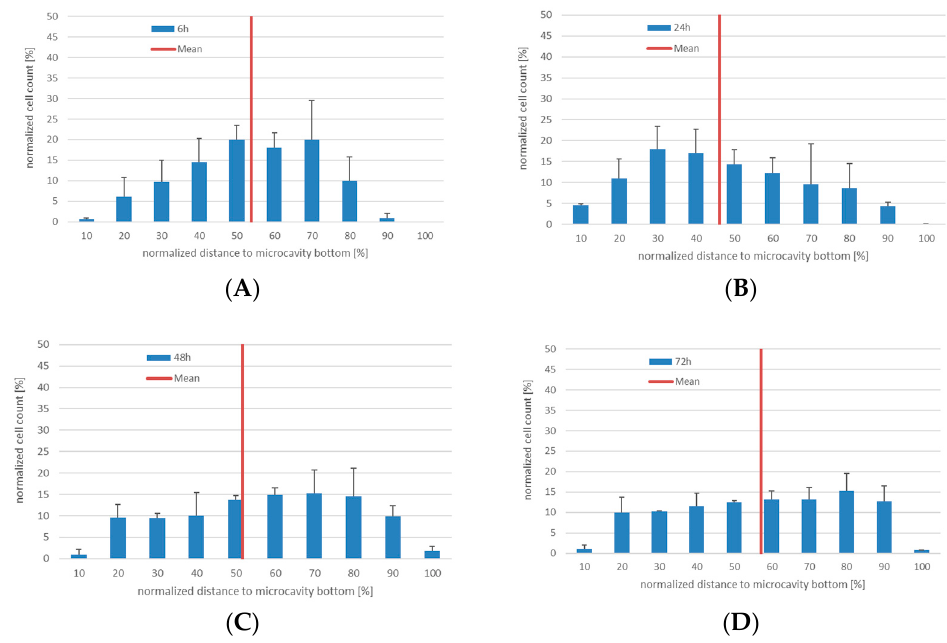
Figure 4. 3D co-culture of human bone marrow MSCs with human KG-1a cells in microcavities. Number of CTG + -cells and their position relative to the cavity bottom (0%). The mean distance is displayed as a red line , n = 3. ( A ) Distribution of KG-1a cells in 3D co-culture after 6 h. ( B ) Distribution of KG-1a cells in 3D co-culture after 24 h. ( C ) Distribution of KG-1a cells in 3D co-culture after 48 h. ( D ) Distribution of KG-1a cells in 3D co-culture after 72 h.